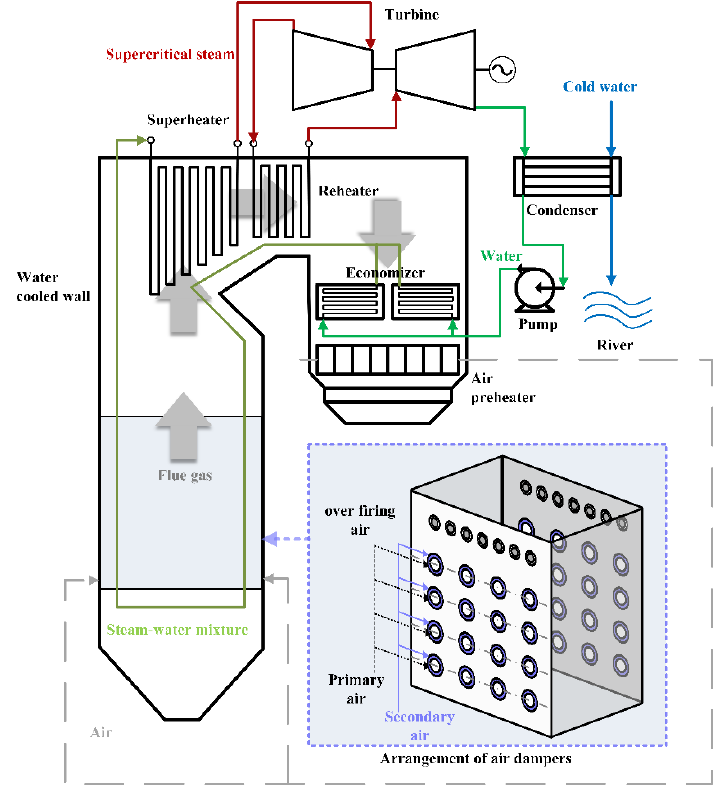
Figure 1. Schematic diagram of the boiler and arrangement of the air dampers. Table 2. Analysis of the combusted